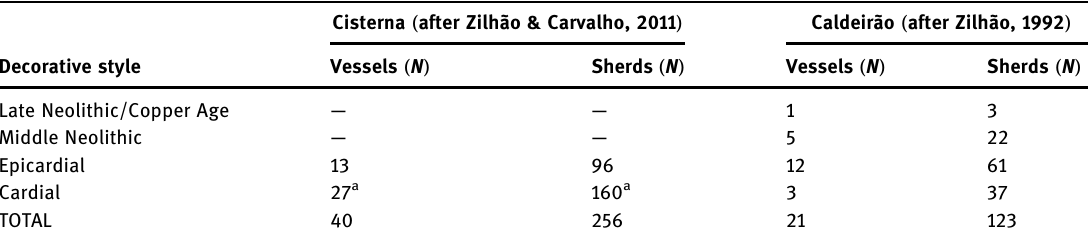
Table 1: Neolithic ceramics from Galeria da Cisterna and Gruta do Caldeirão Cisterna ( after Zilhão & Carvalho, 2011 ) Caldeirão ( after Zilhão, 1992